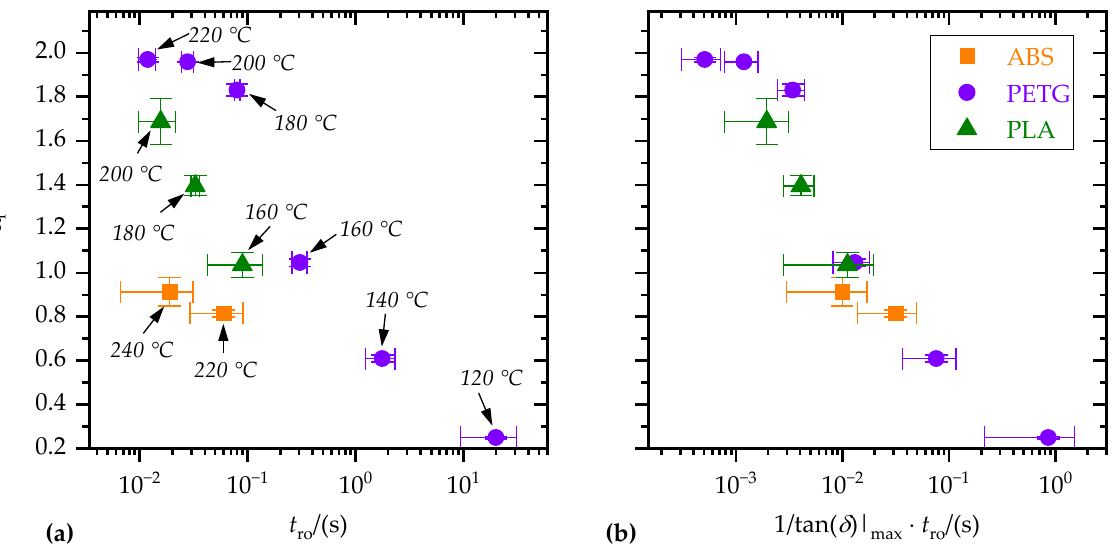
Figure 13. Equilibrium contact angle, φ eq , as a function of ( a ) Rouse relaxation time, t ro , and ( b ) Rouse relaxation time, t ro , and maximum loss factor, tan( δ )| max . Corresponding substrate temperatures, T s,1 , are indicated.